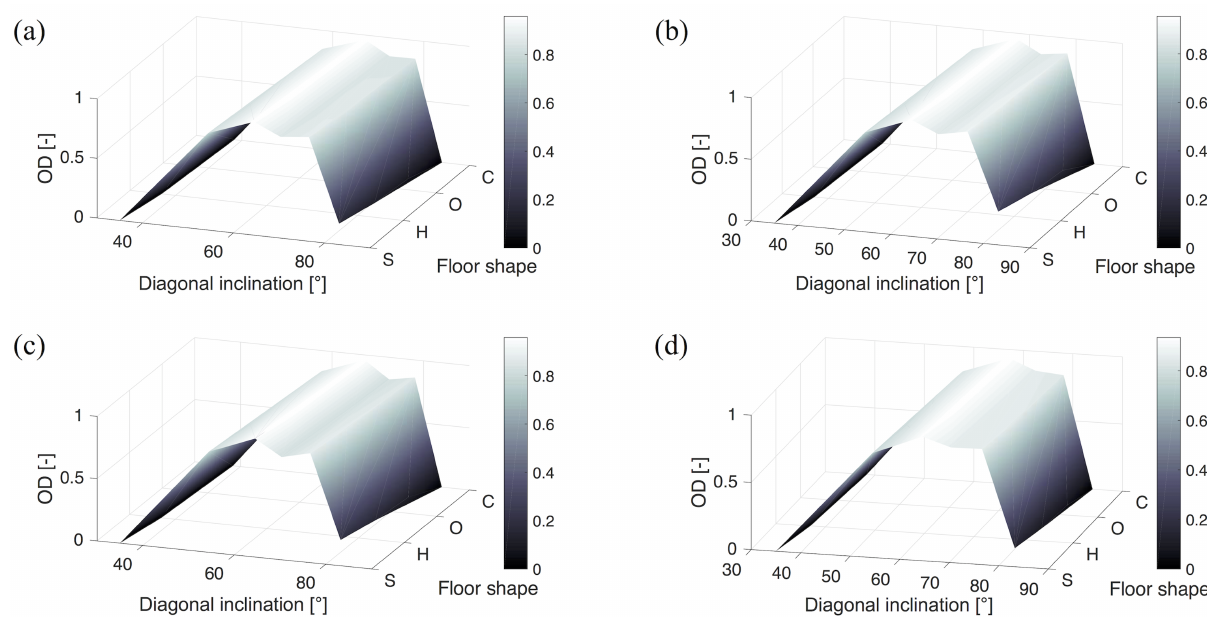
Figure 4: Surface representation of the OD with respect to the diagrid geometrical parameters obtained with different combinations of the individual desirability exponents: (a) r δ = 2.00 , r ϕ = 1.00 , r M = 1.00 , r CI = 1.00 ; (b) r δ = 1.50 , r ϕ = 0.75 , r M = 1.25 , r CI = 1.00 ; (c)